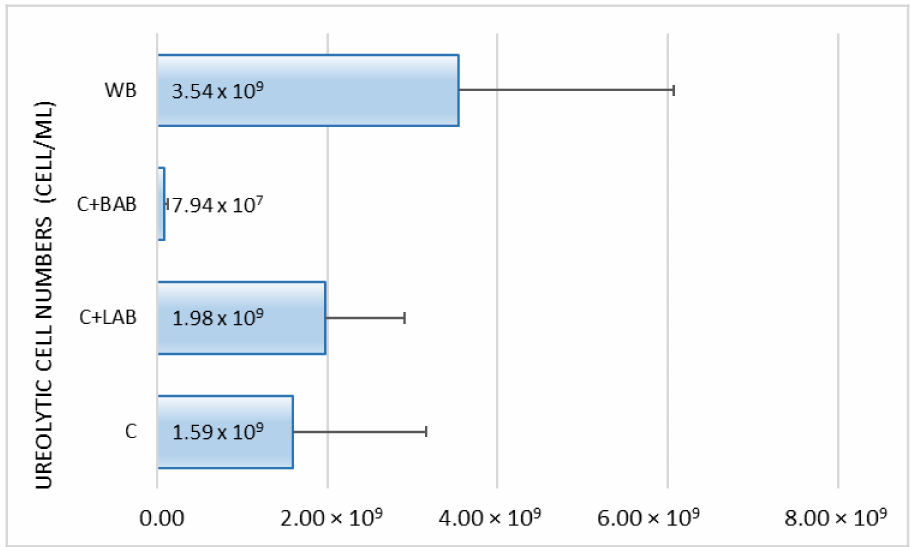
Figure 2. Number of ureolytic bacteria of the